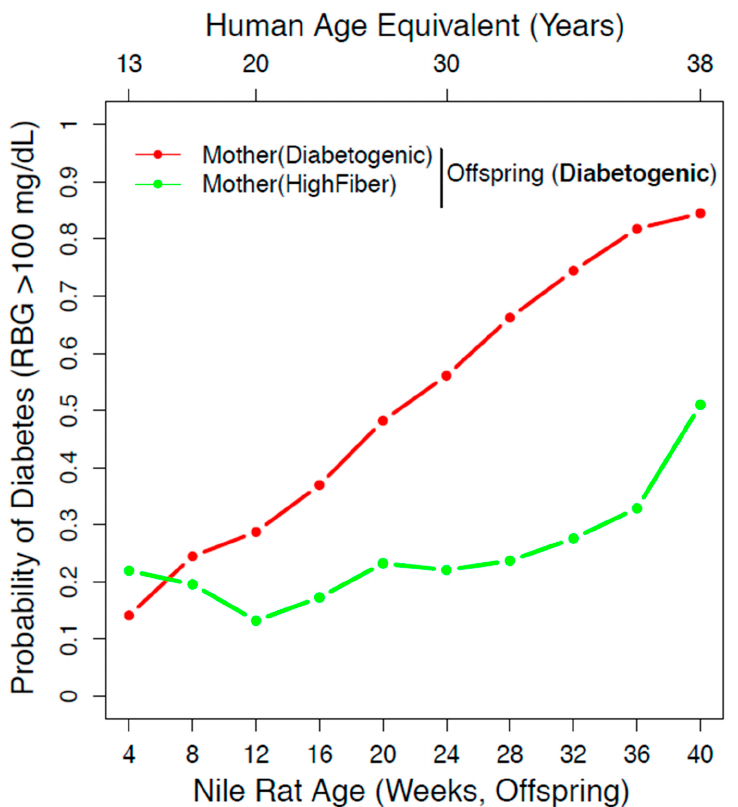
Figure 4. Offspring have a reduced probability of diabetes when mothers consumed a high-fiber diet. We used a simple Bayesian network that incorporated maternal diet, offspring diet, and sex to calculate the probability of diabetes due to maternal diet differences. When the offspring is on a diabetogenic diet, the probability of diabetes is greatly reduced in the group with a maternal high-fiber diet compared to a maternal diabetogenic diet. The number of Nile rats: n = 95 (green), n = 355 (red).